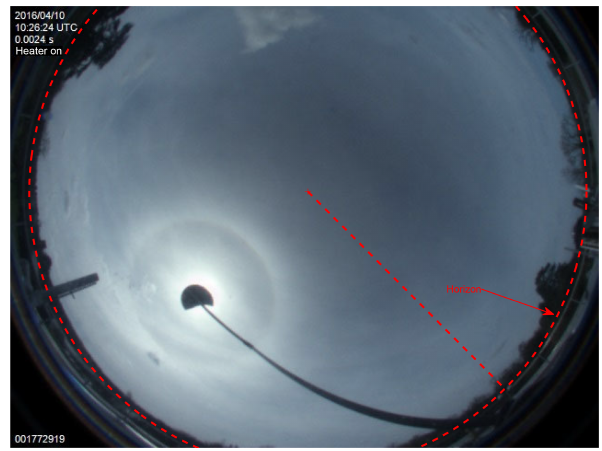
Figure 2. Predicted (blue dots, from Eqs. 1 and 2) and actual (red dots) star and planet trajectories. Each trajectory is labelled with the name of the star or planet and the mean angular difference between predicted and actual positions.